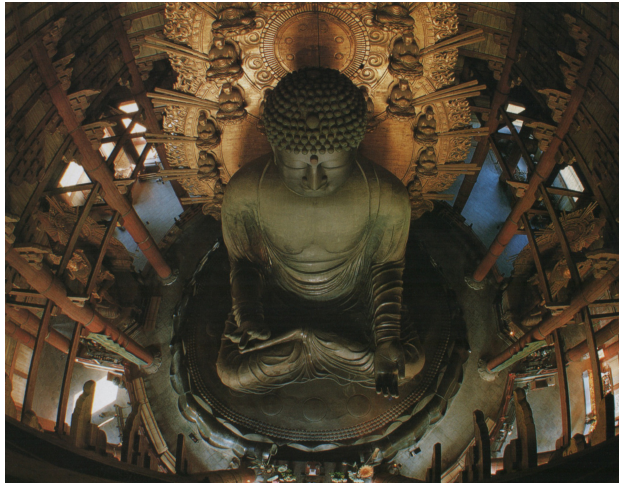
Figure 1. Seated Vairocana Buddha. Daibutsuden, T ō daiji, Nara prefecture. Gilt bronze. Nara pe- riod, mid 8th century. Reproduced from ( Ō tsuka 1999, p. 10).